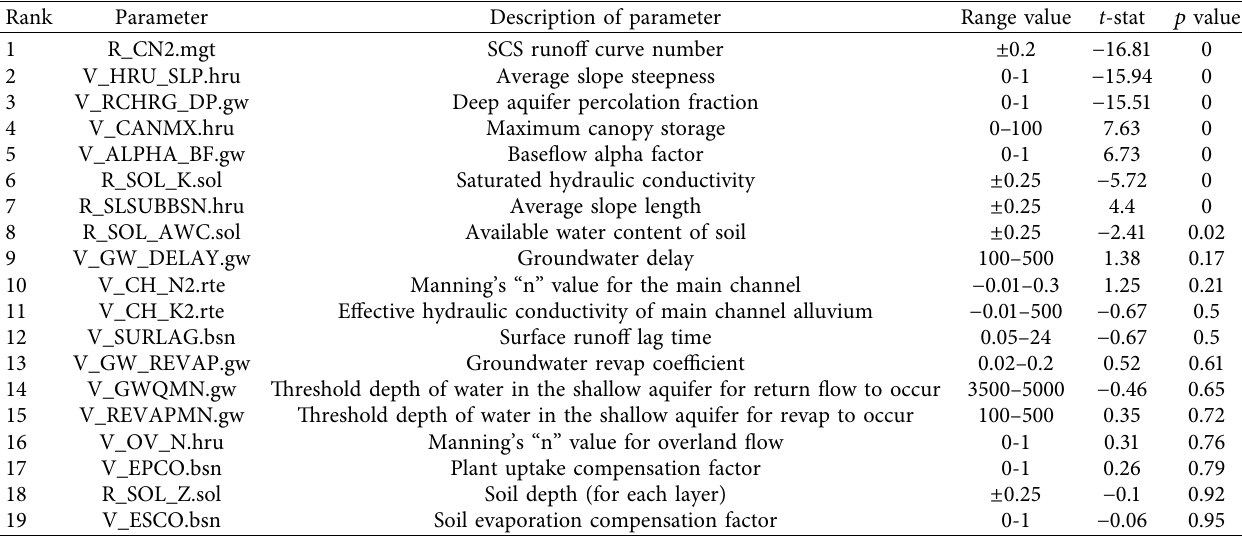
Table 6: Streamflow calibration parameters and their sensitivity